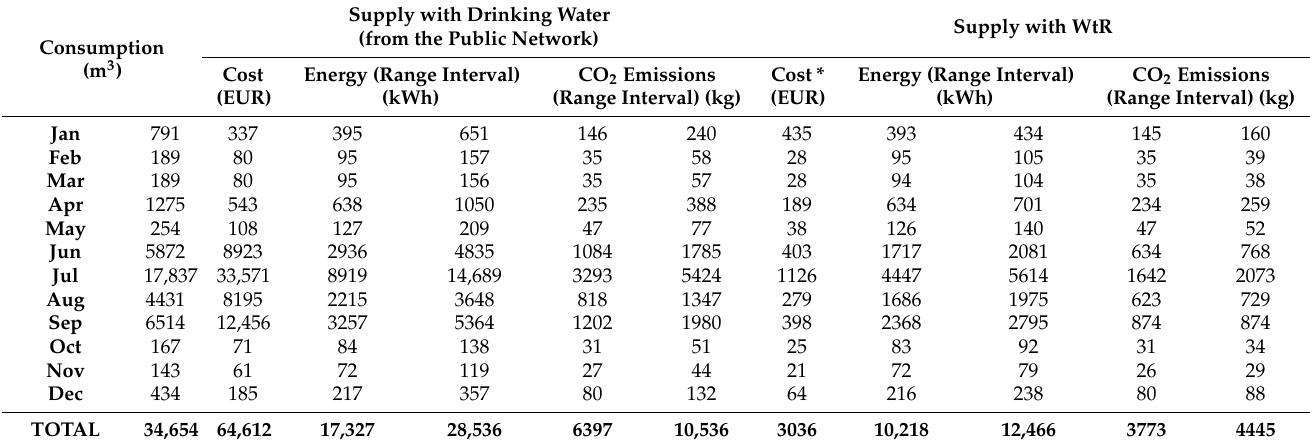
Consumption (m 3